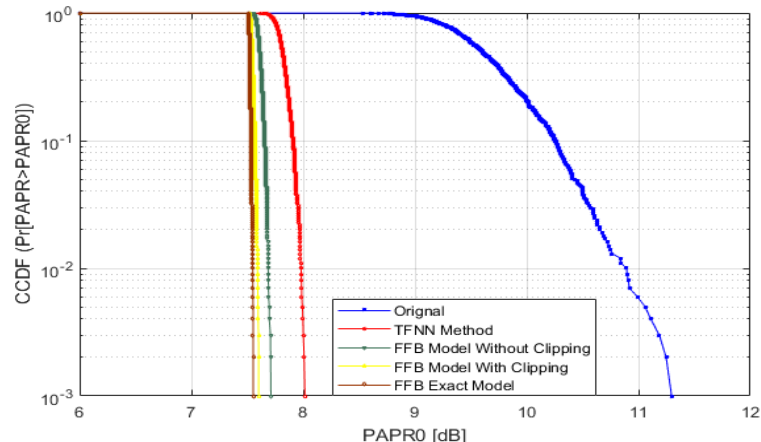
Figure 7. Complementary cumulative distribution function (CCDF) of PAPR performance for proposed and conventional schemes.